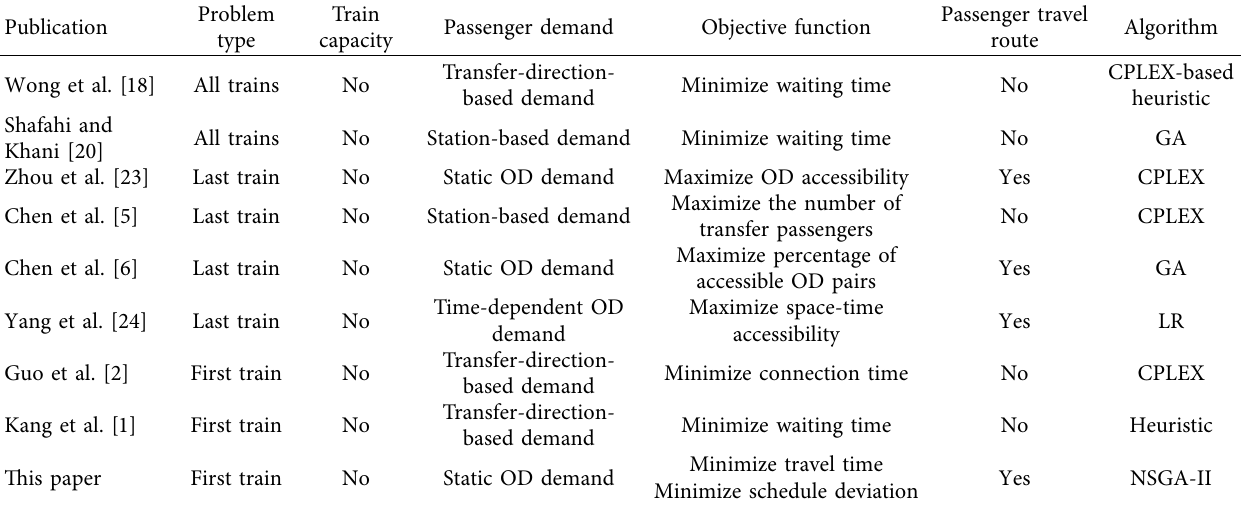
Table 1: Comparison between this paper and the most relevant